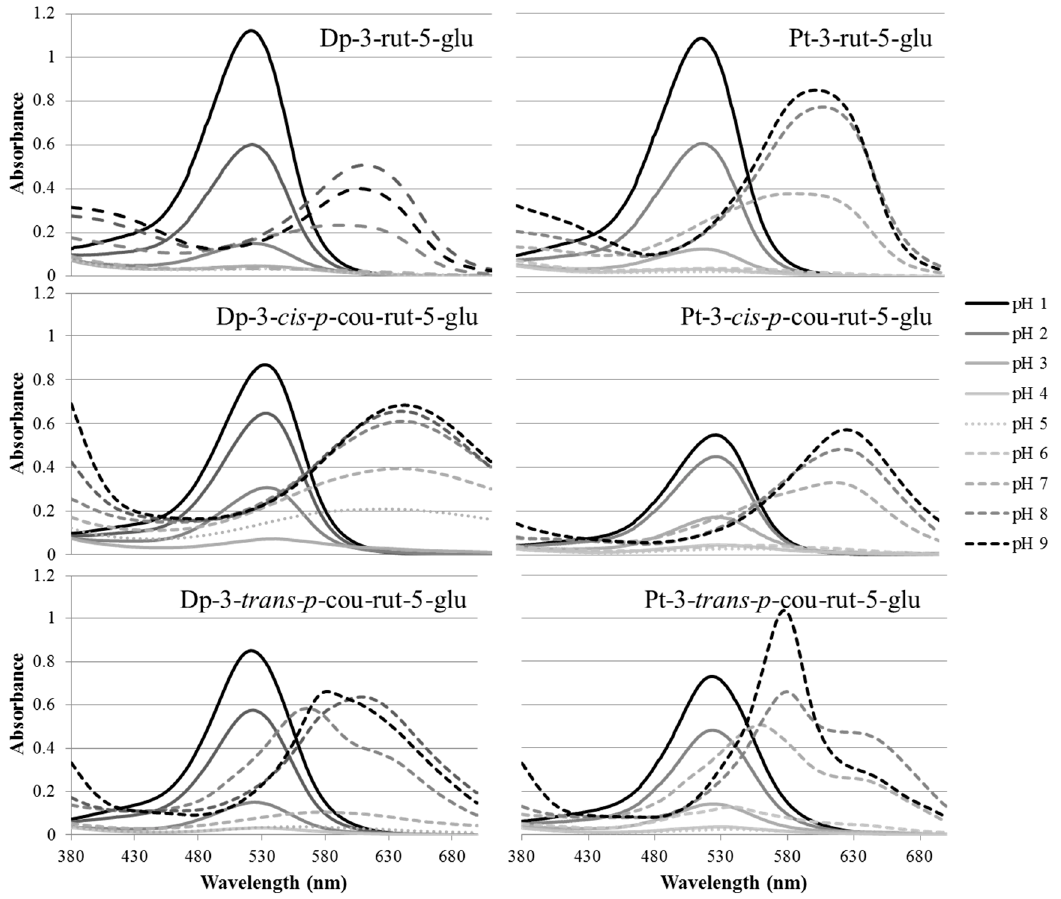
Figure 2. Visible absorbance (380–700 nm) of isolated delphinidin (Dp) and petunidin (Pt) derivatives, pH 1–9.